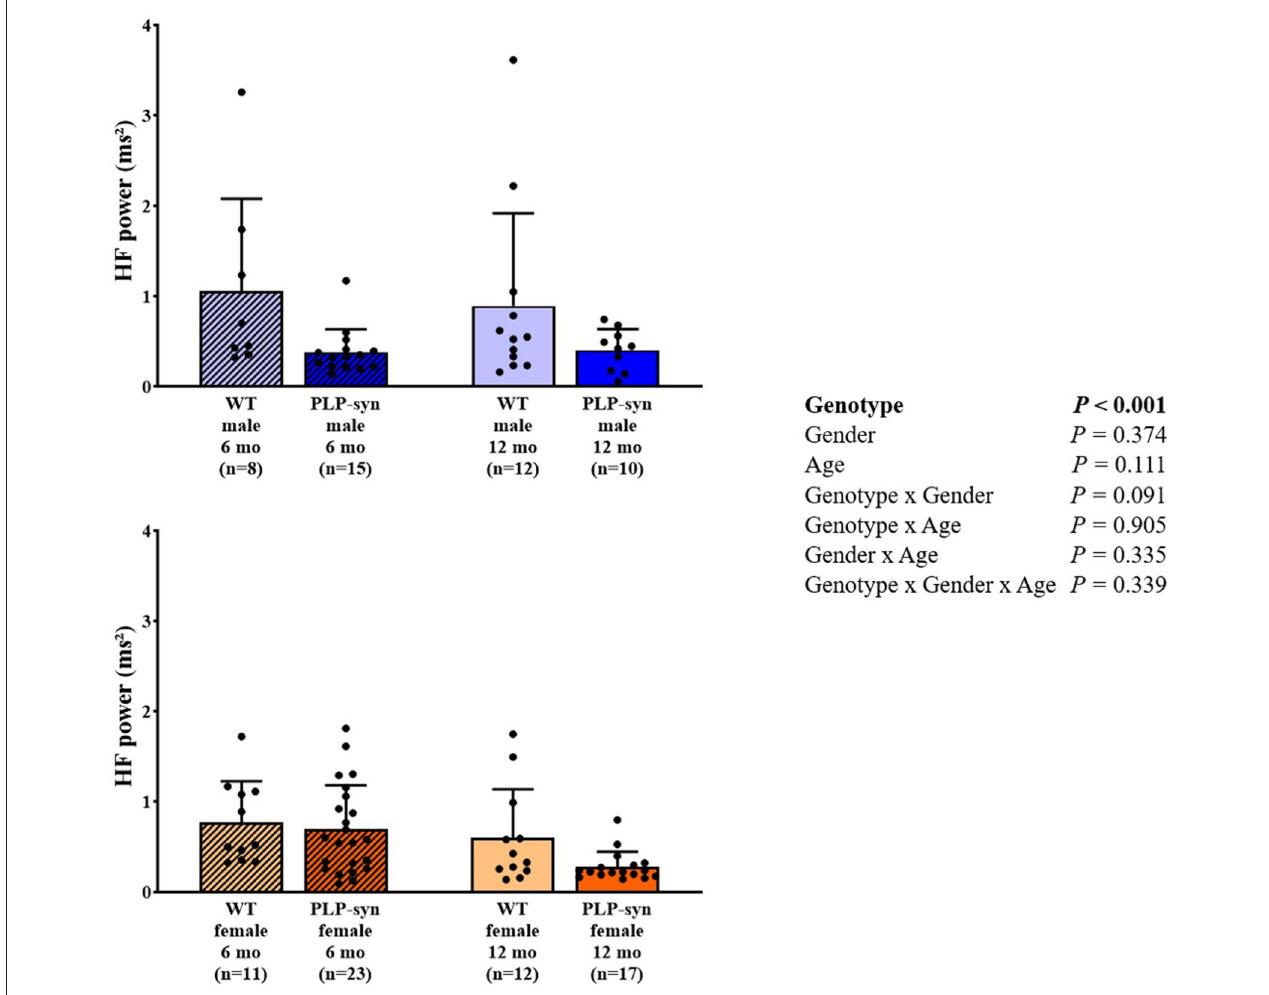
FIGURE 4 | HF power in 6 and 12 months, male and female, WT and PLP- α -syn mice. HF, high frequency. Black circles represent individual points.